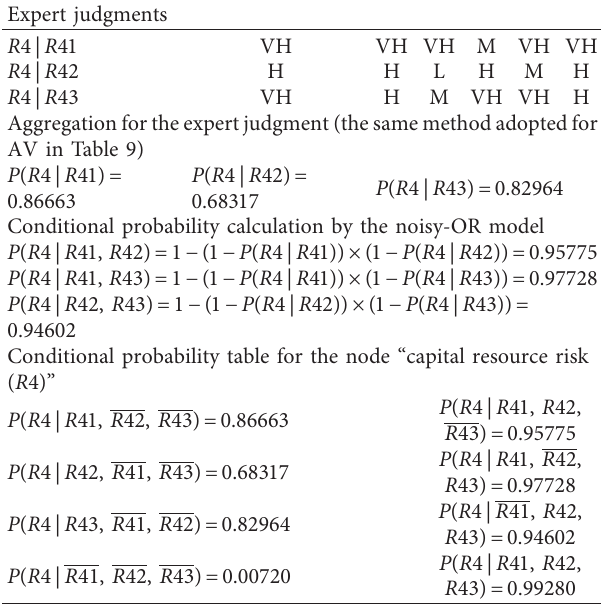
Table 8: The CPT of the node “capital resource risk ( R 4).” Expert judgments